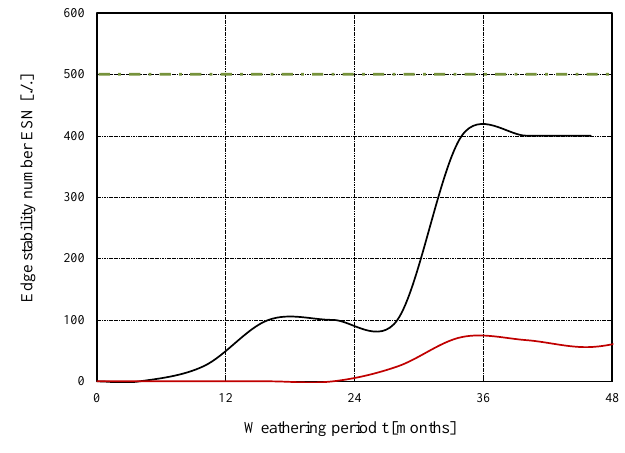
Fig. 2 Comparison of the edge stability as a function of the edge stability number over the weathering period of conventional PVB film (Saflex ® -RB41, black curve) and structural PVB film (Saflex ® -DG41, red curve) according to Stevels and Haller